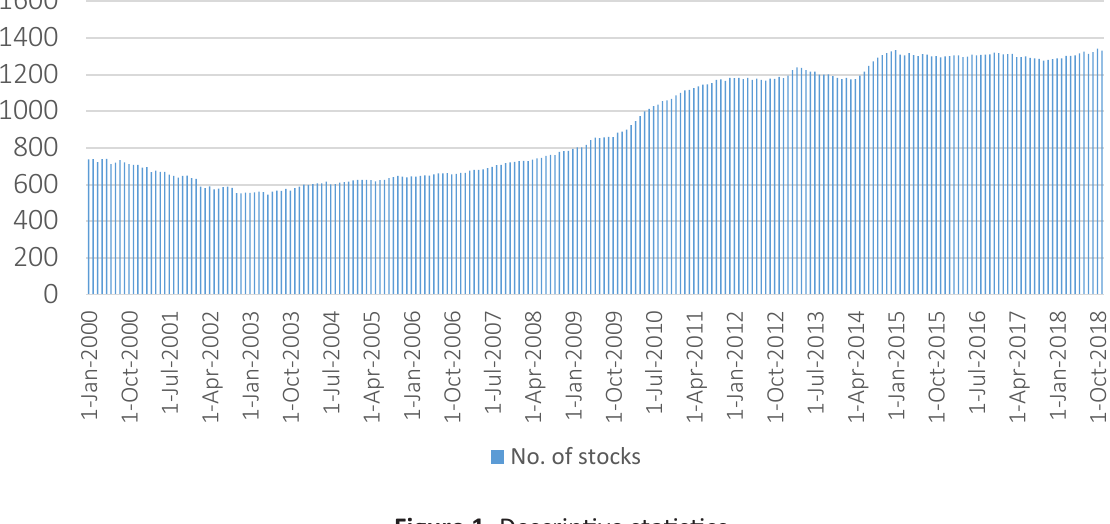
Figure 1. Descriptive